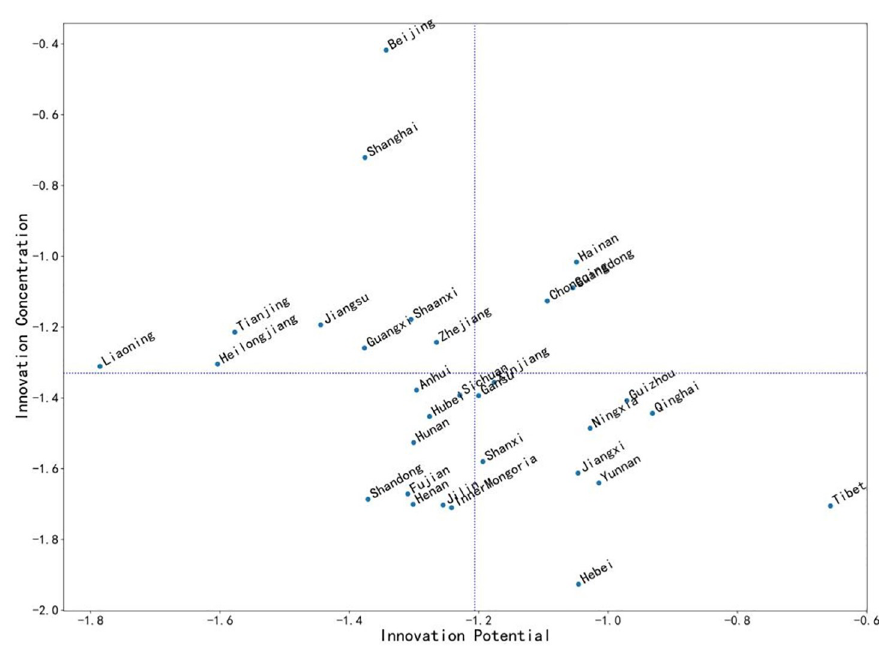
Fig 3. Distribution of innovation potential—Innovation concentration by province (hierarchical